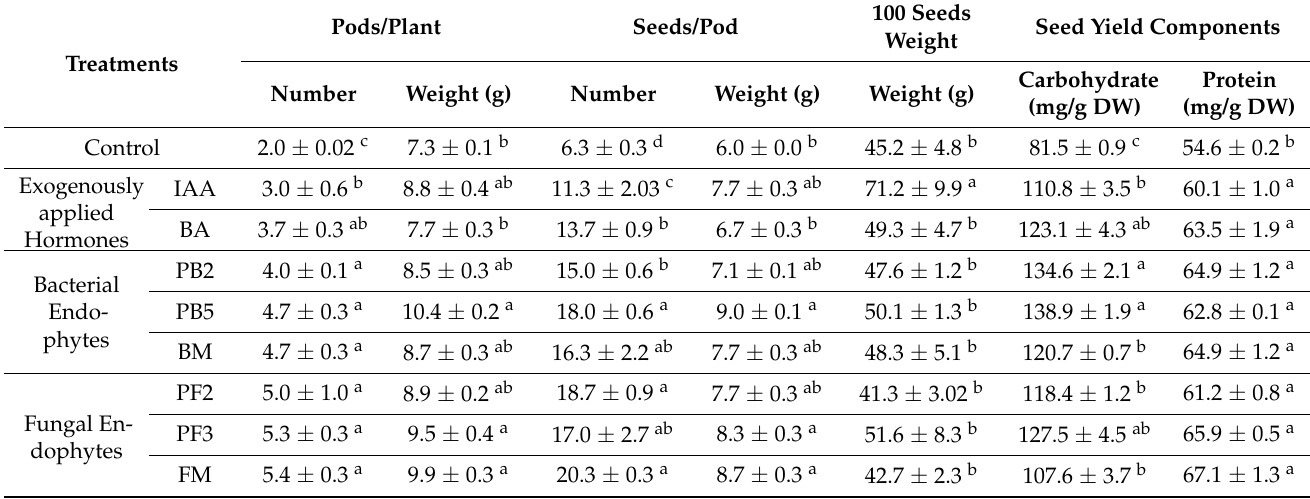
Table 7. Effect of foliar spraying of exogenously applied hormones and microbial endophyte metabolites on yield parameters and seed yield components of common bean